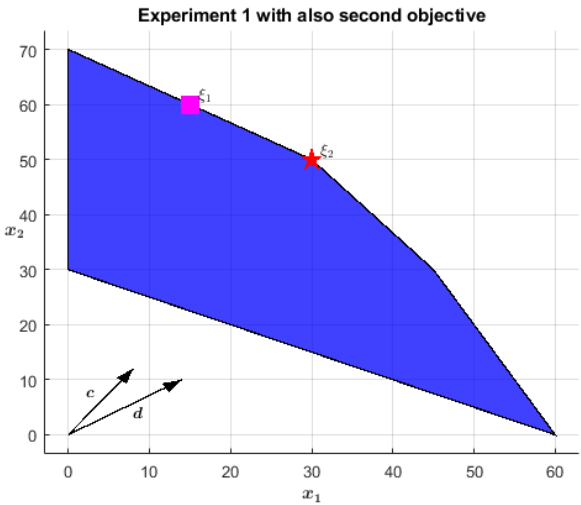
Figure 2. ξ 2 is the only optimal solution when both objectives are